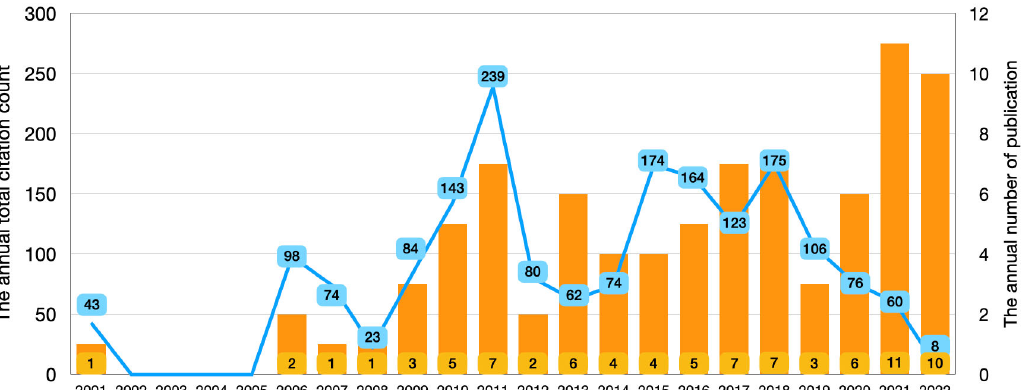
Figure 5. The annual total citation counts and the production of haptic and force feedback technology studies in dental education from 2001 to 2022.